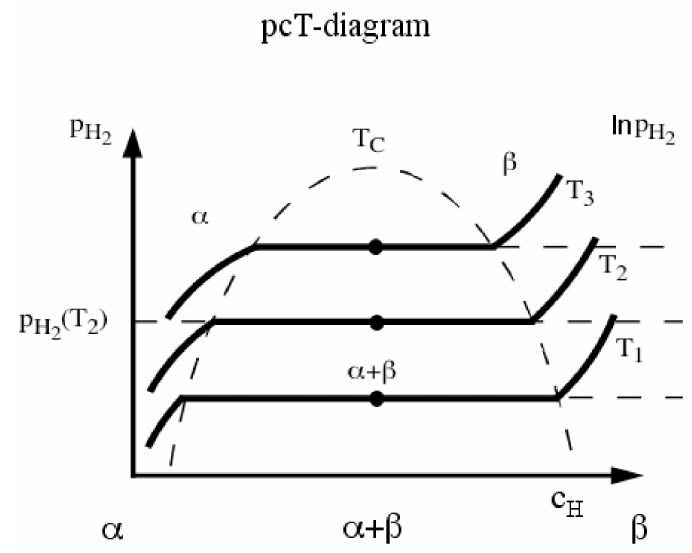
Figure 2. Schematic pcT-diagram. The α -phase is the solid-solution phase, whereas the β -phase is the hydride phase. Within the ( α – β ) two-phase region, both the metal-hydrogen solution and the hydride phase coexist